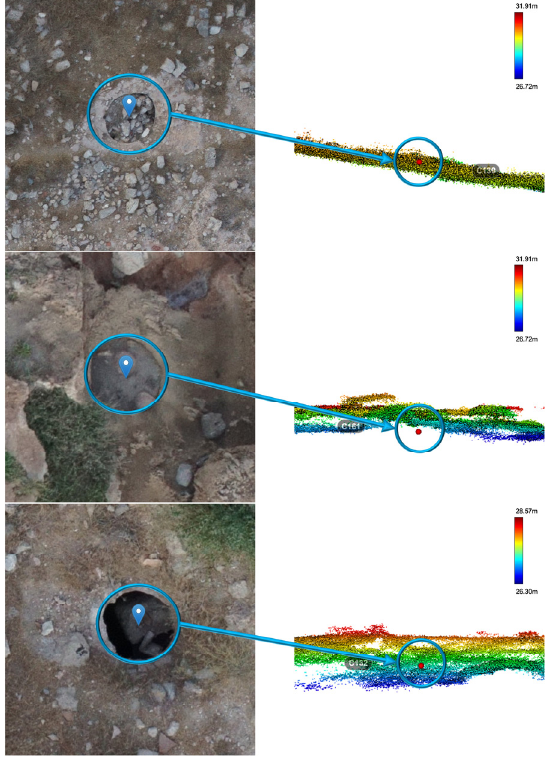
Figure 32. Sample false negatives caused by cisterns fi lled with debris.